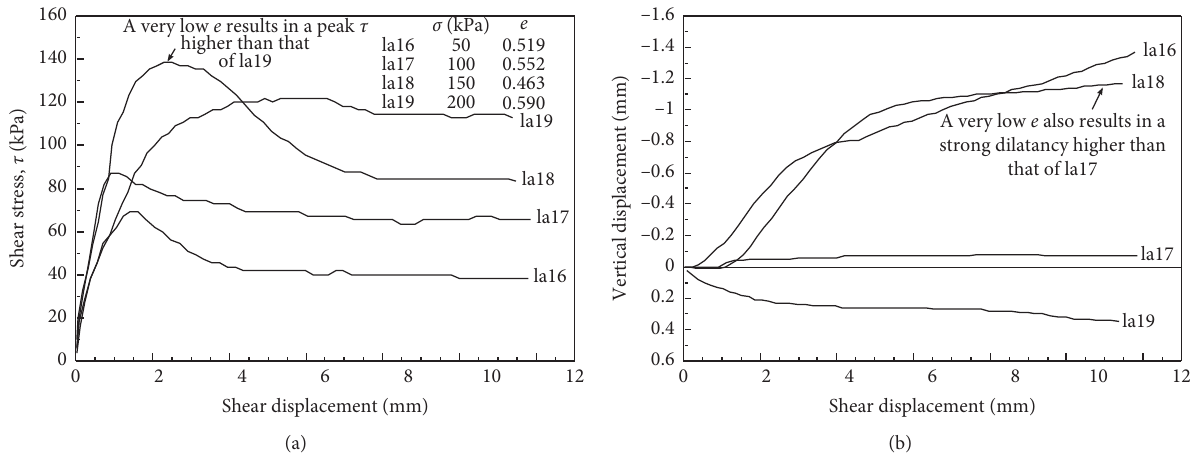
Figure 11: Data of the laboratory tests in humid condition. (a) Shear stress versus shear displacement. (b) Vertical displacement versus shear